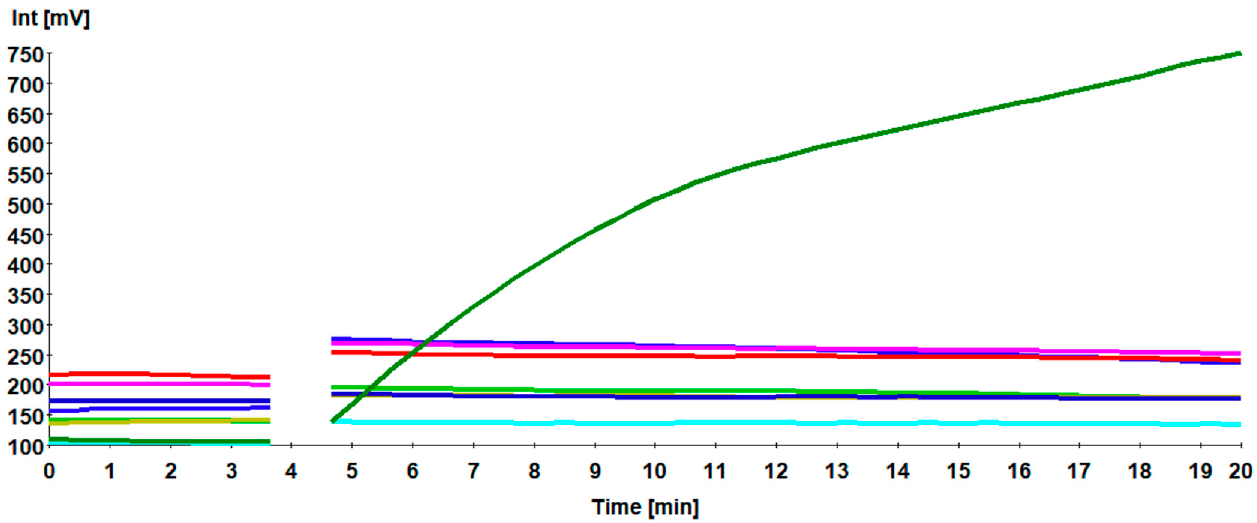
Figure 3. Assay cross reactivity. Only the RNA of aINF H9N2 was amplified (dark green). Nucleic acids of influenza viruses H5N2 (blue), H7N1 (magenta), and ILTV (red), IBV (cyan), NDV (light green), of Mycoplasma gallisepticum (khaki) as well as negative control (dark blue) were not detected.